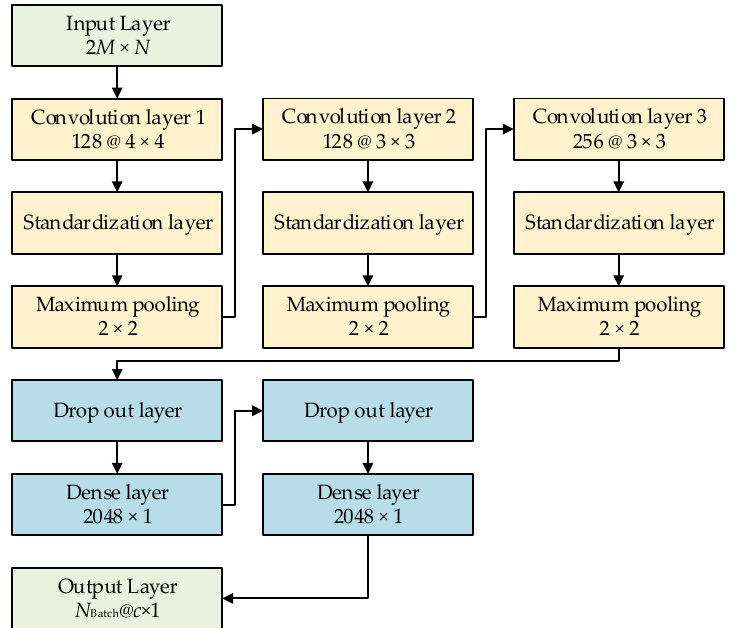
Figure 2. Schematic of a typical convolutional neural network.